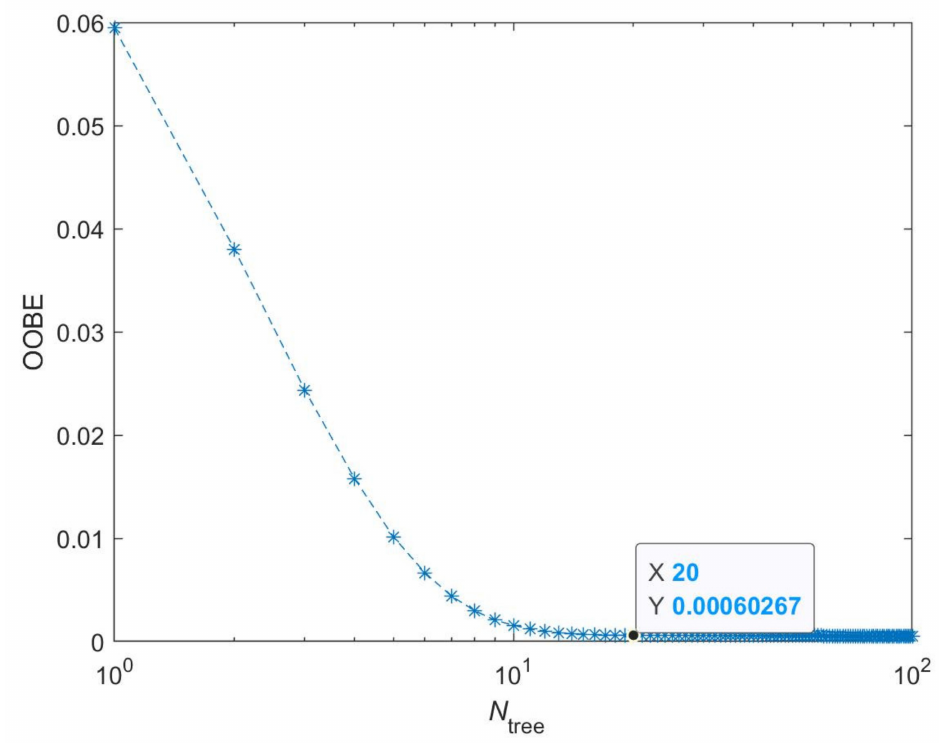
Figure 3. Variation of the OOBE with the N tree increasing from 1 to